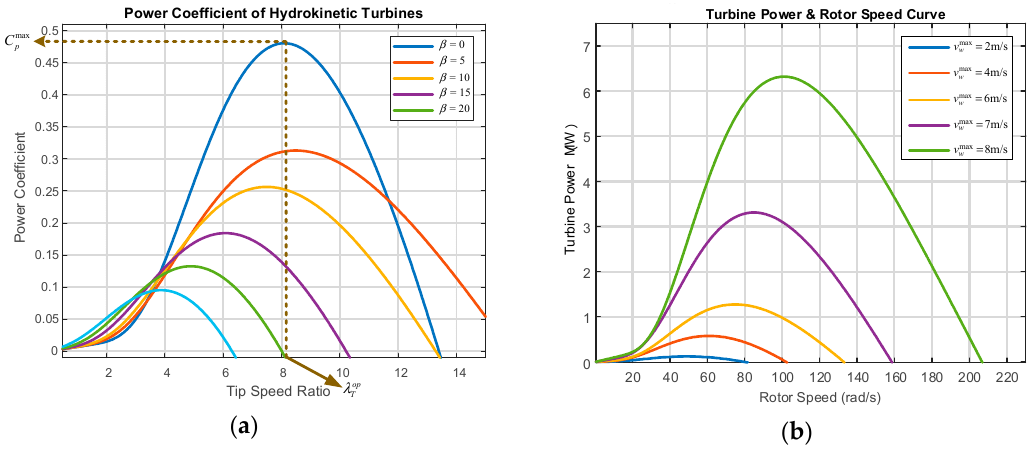
Figure 2. ( a ) Relationship between tip speed ratio and power coefficient; ( b ) hydrokinetic turbine power for different maximum amplitude of tidal current speed.